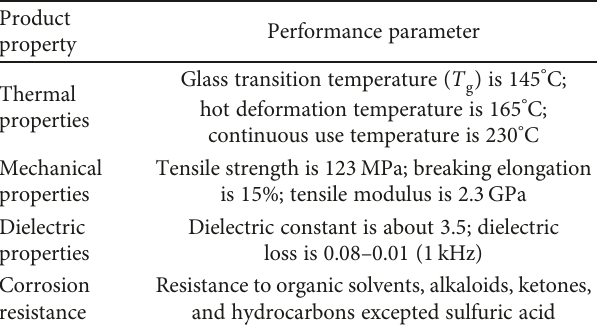
Table 1: Properties of PEN ID-300.